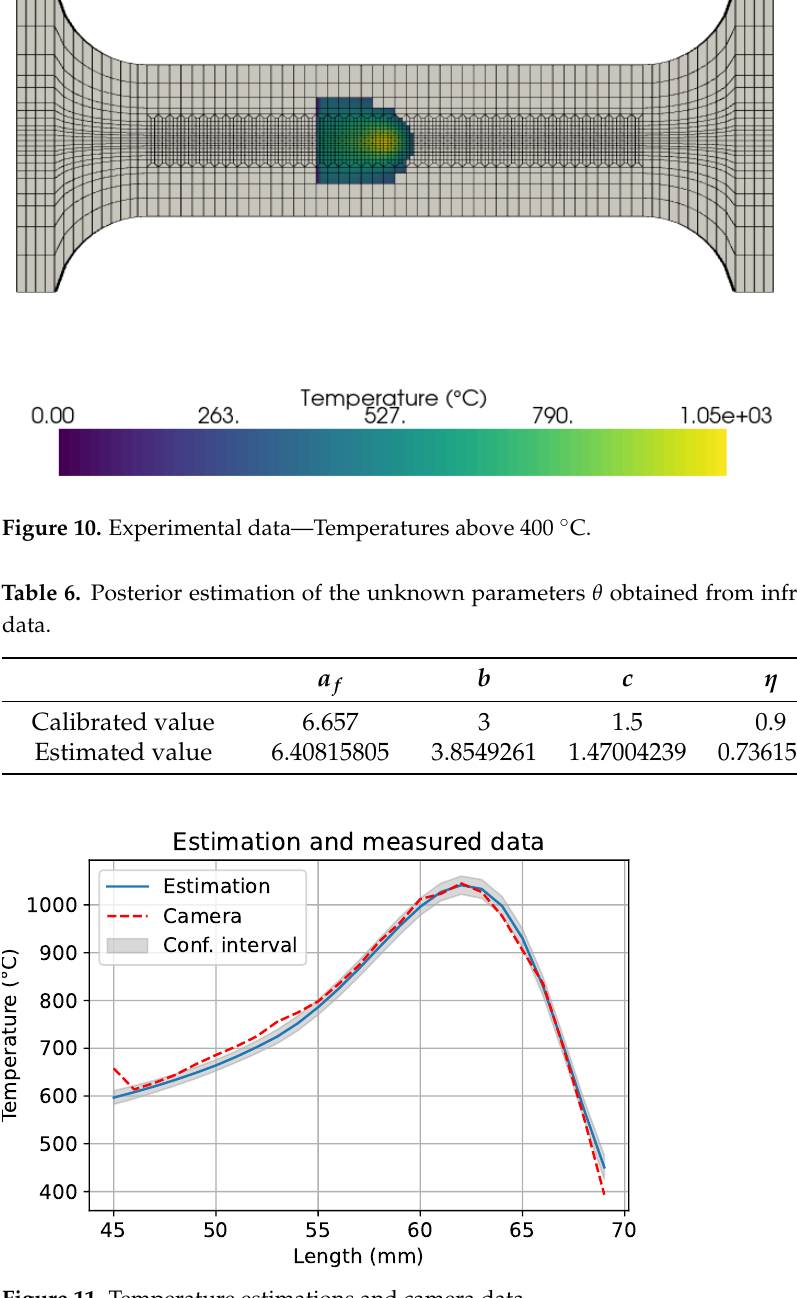
Figure 11. Temperature estimations and camera